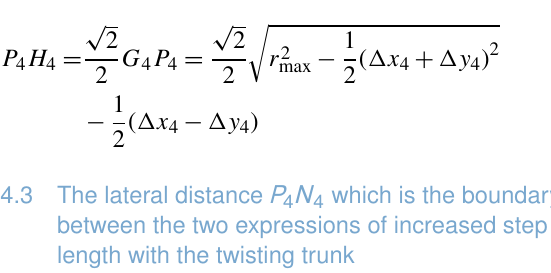
is the far- 4 F (cid:48)(cid:48) is the farthest foothold 4 4